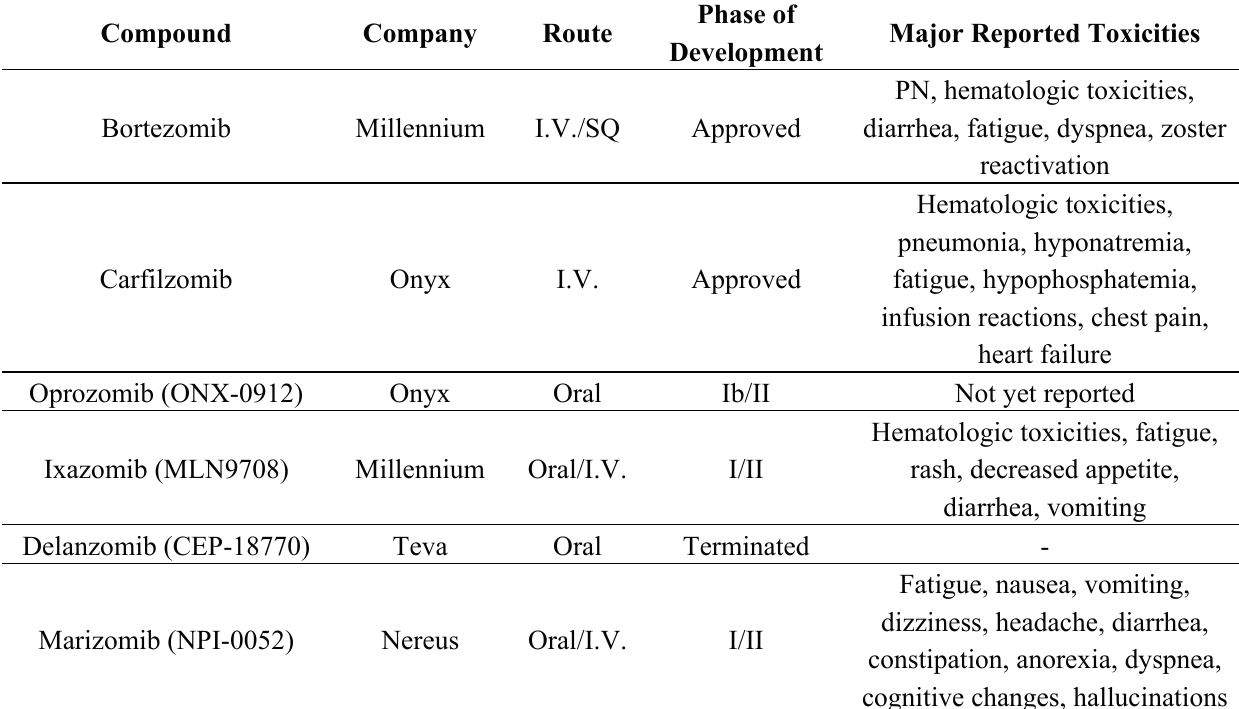
Table 1. Proteasome inhibitors in clinical